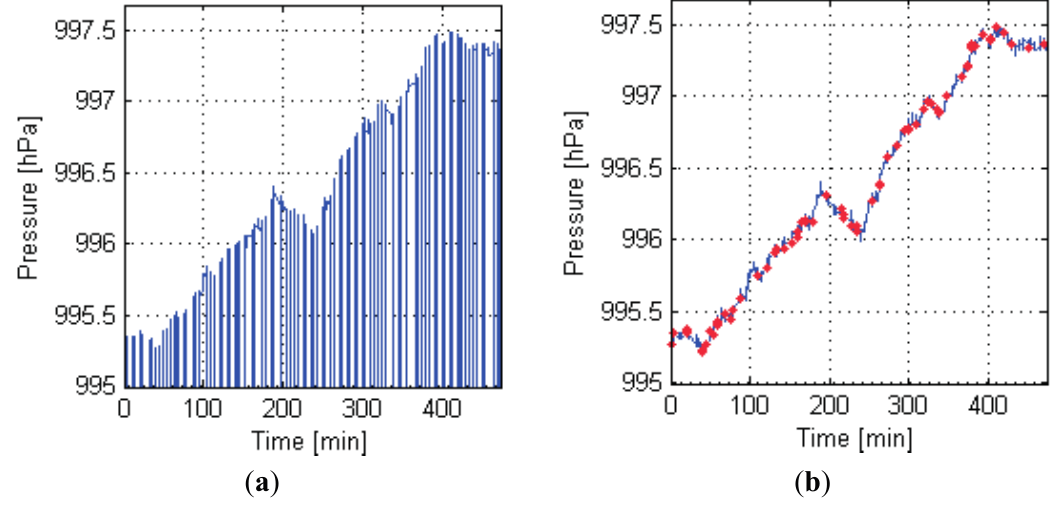
Figure 7. Measurement process by Mi3 with BMP180. ( a ) Raw data; ( b ) Results when outliers are